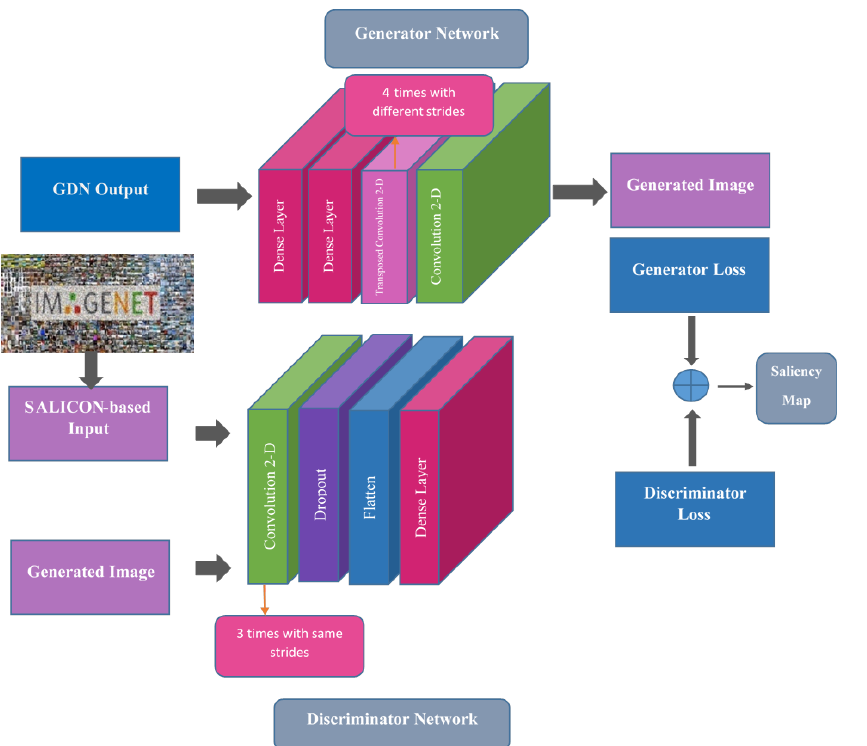
Figure 5. The block diagram of the GAN part of the proposed GDN-GAN for saliency reconstruction.